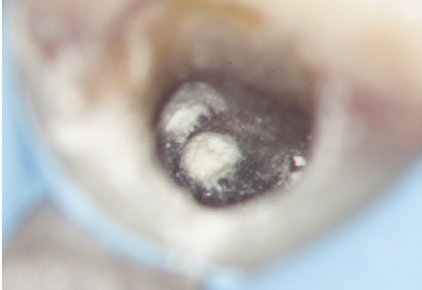
Figure 6: Both perforations covered with MTA.